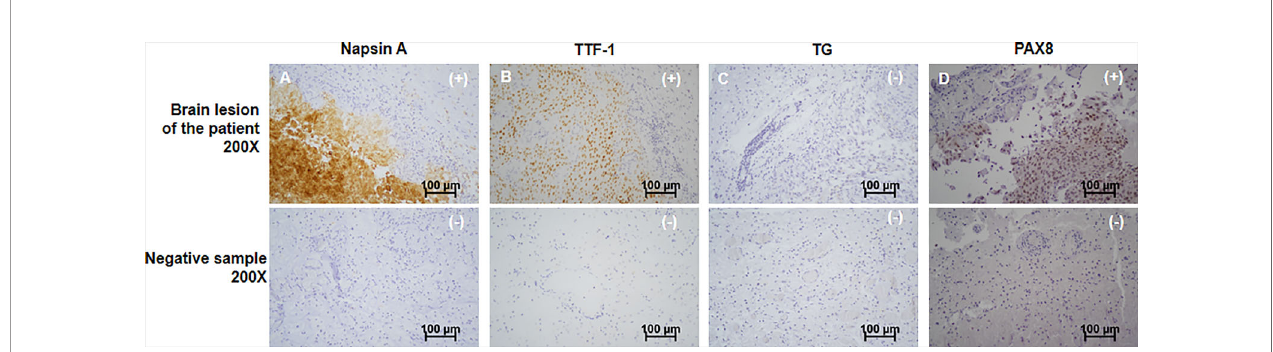
FIGURE 2 | Immunohistochemistry of the patient ’ s brain cancer. From top to bottom, the immunochemistry results of the patient ’ s brain tumor and negative control sample were shown. The patient ’ s tumor showed positive of Napsin A (A) , TTF-1 (B) and PAX8 (D) , showing as “ (+) ” in top right corner of the graphs. Negative of